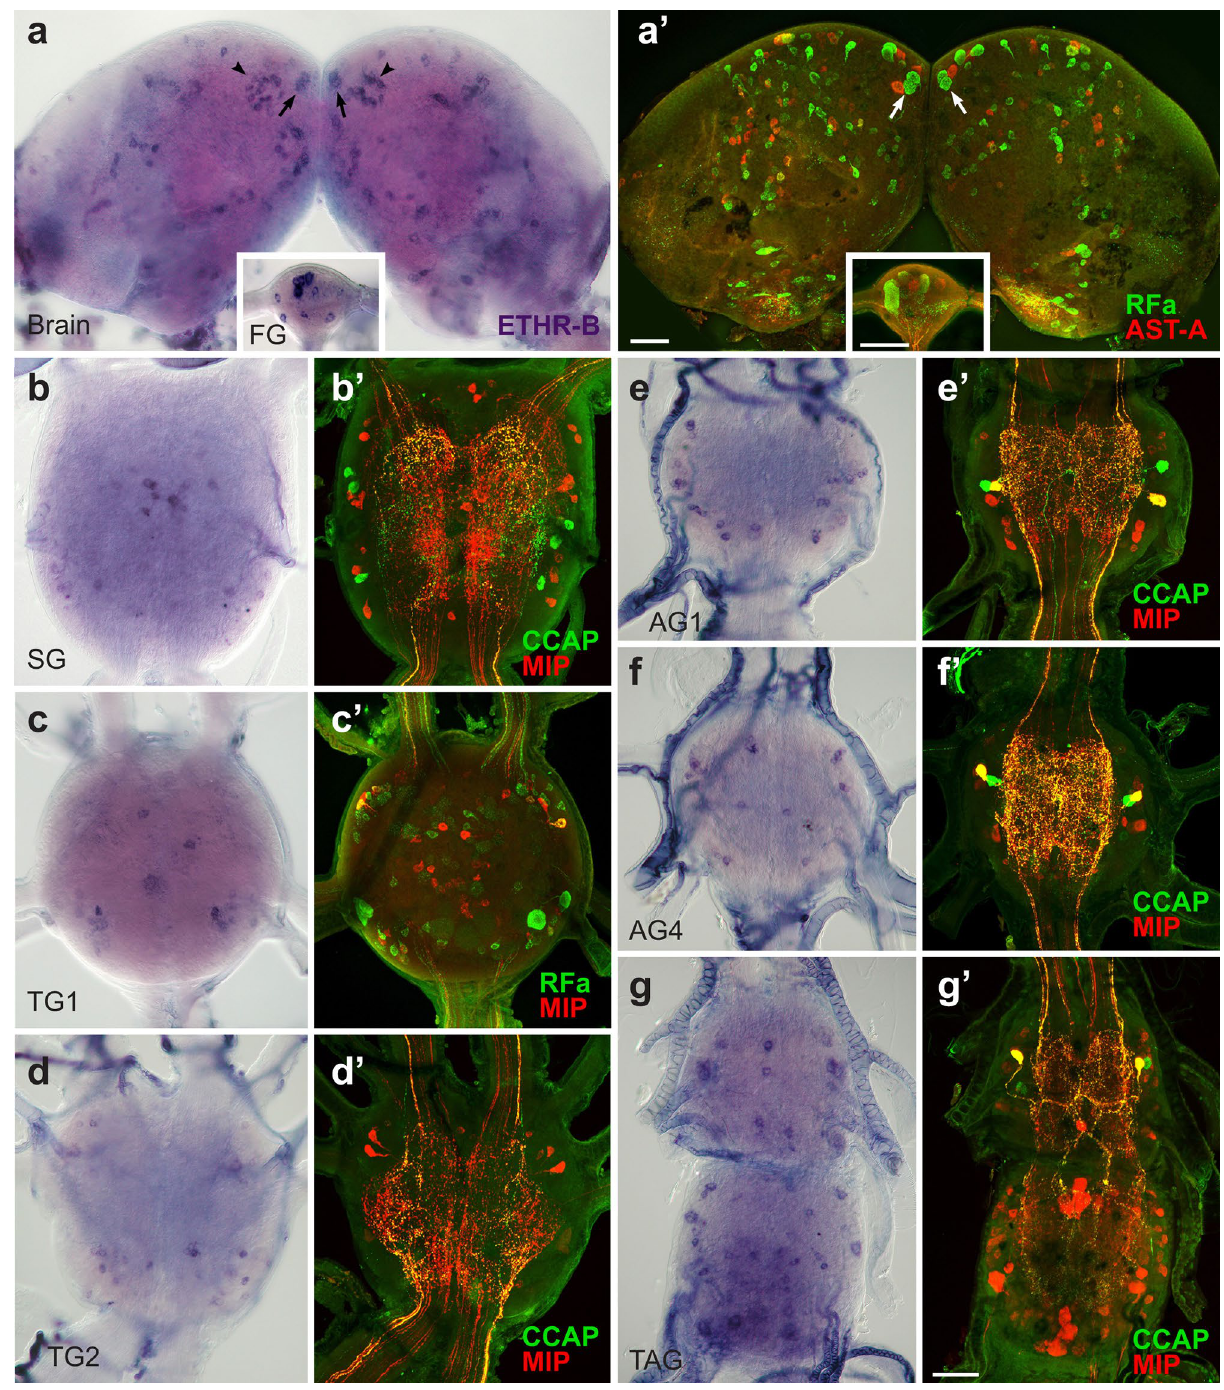
Figure 9. ETHR-B expression in the CNS of pharate pupae. ( a–g ʼ ) ISH using ETHR-B probe followed by immunostaining of the same ganglia with antibodies to various neuropeptides. ( a–a’ ) Brain cells IIa 5 producing ETHR-B and MS (RFa antibody binds to MS C-terminal) (arrows; green) and two clusters of small neurons that probably coexpress both receptor isoforms (arrowheads). Other small ETHR-B neurons were not labelled with antibodies to RFamide (green) and AST-A (red). ( a , a’ ; inset) ETHR-B staining in 8–10 small neurons of the FG that was not colocalized with RFamide (green) or AST-A (red). ( b–g’ ) Numerous ETHR-B neurons in ventral ganglia that failed to react with antibodies to CCAP and MIP ( b ʼ , d ʼ –g ʼ ; green/red) or RFamide and MIP ( c ʼ ; green/red). Scale bars = 50